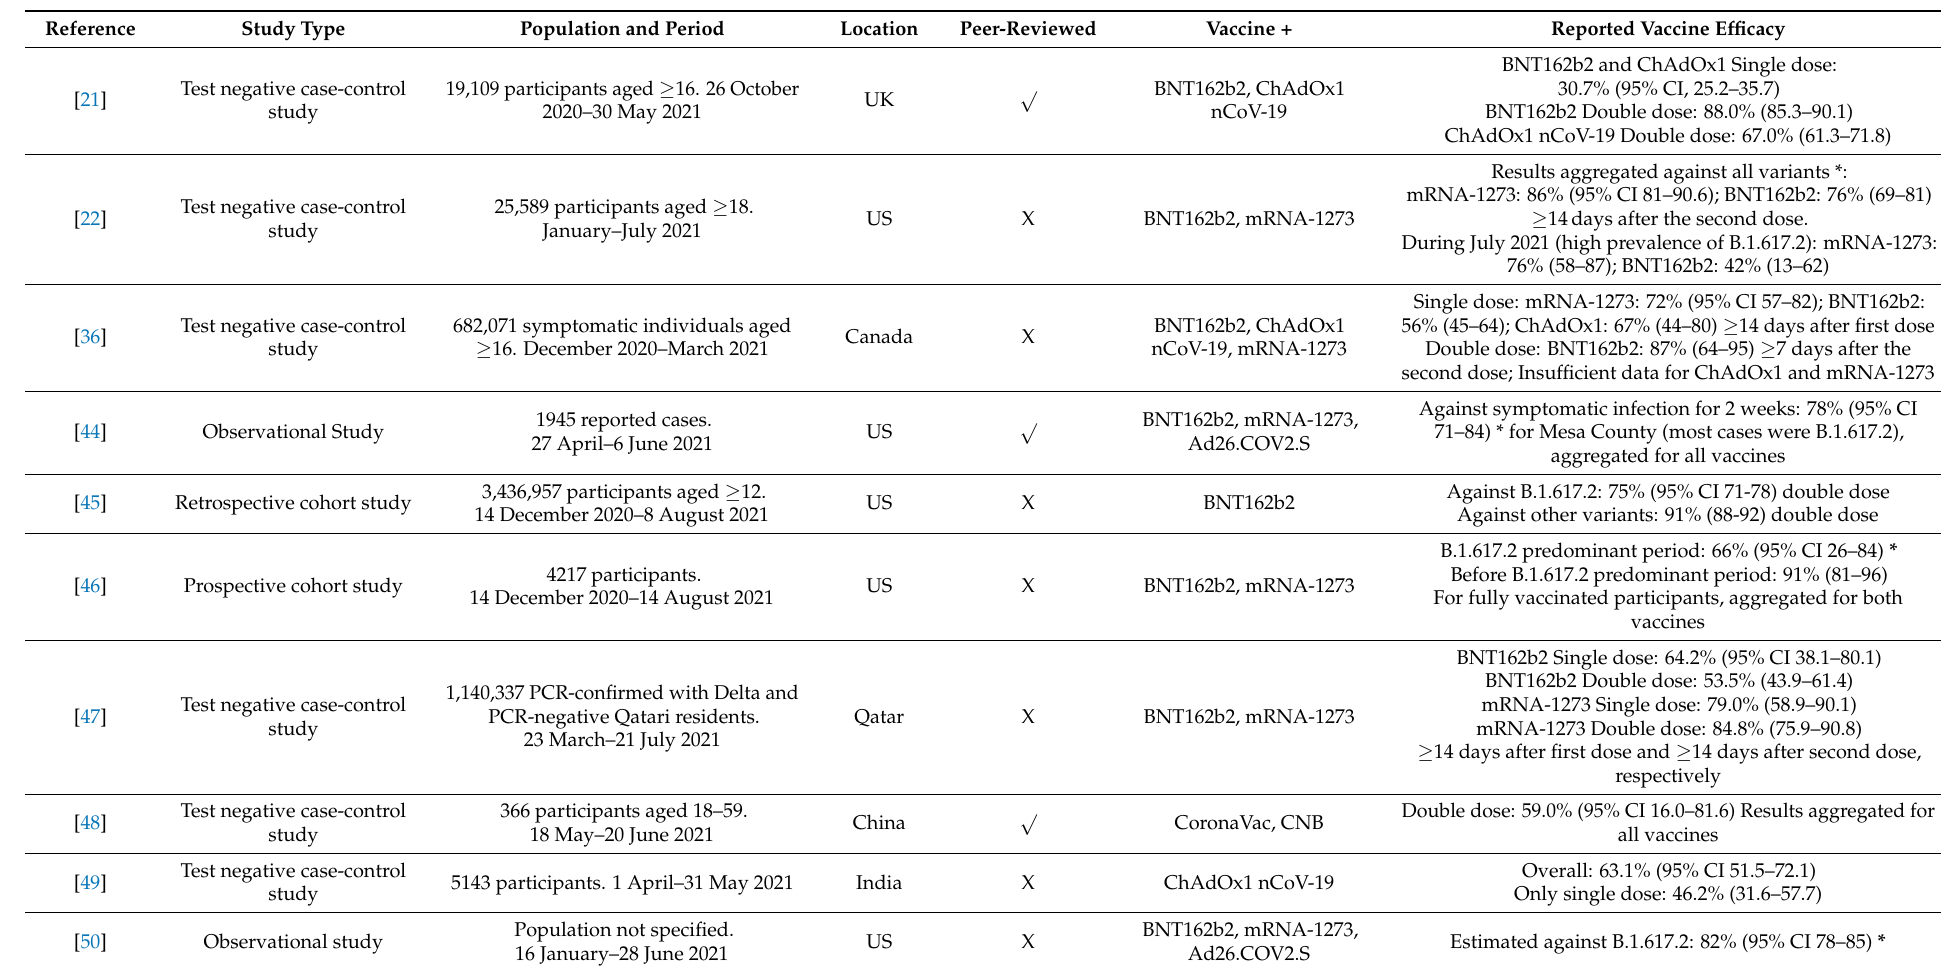
Table 4. Vaccine Effectiveness Against Delta (B.1.617.2)